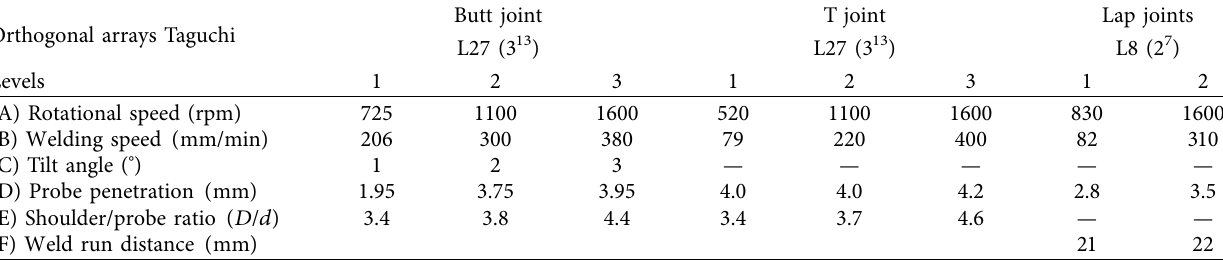
Table 1: Experimental design for each joint arrangement is planned